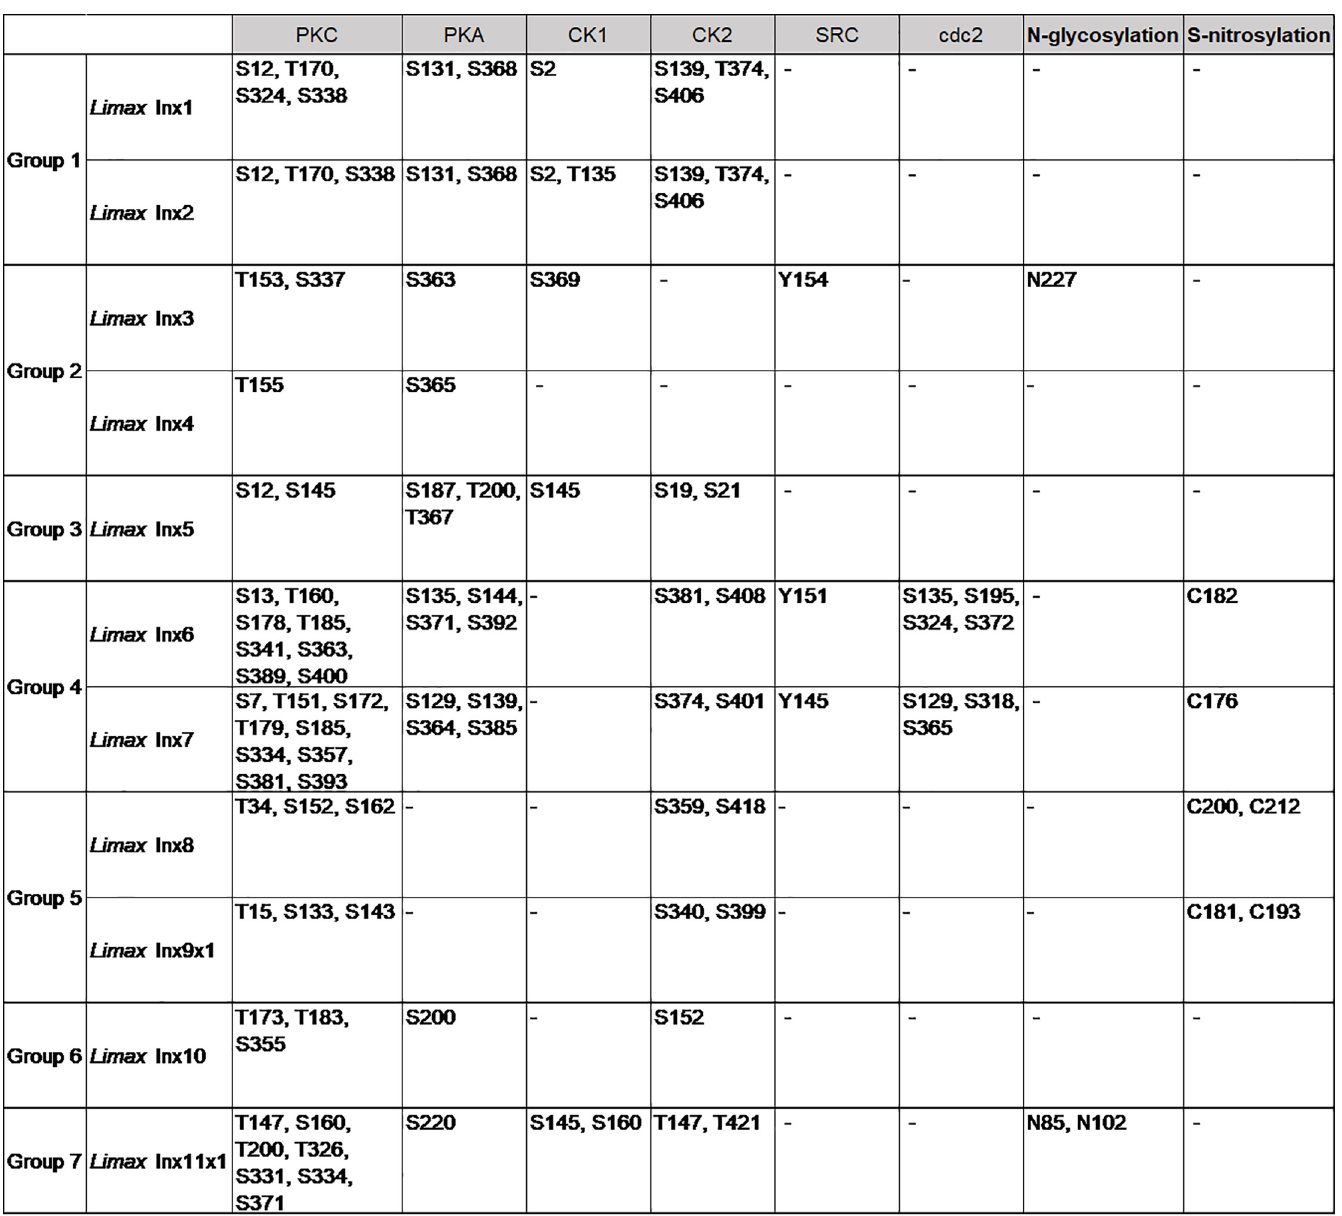
Fig 10. Summary of the predicted modification sites in the innexin orthologs of the seven groups. The conserved modification sites between Limax innexin sequence and at least one other ortholog sequence are